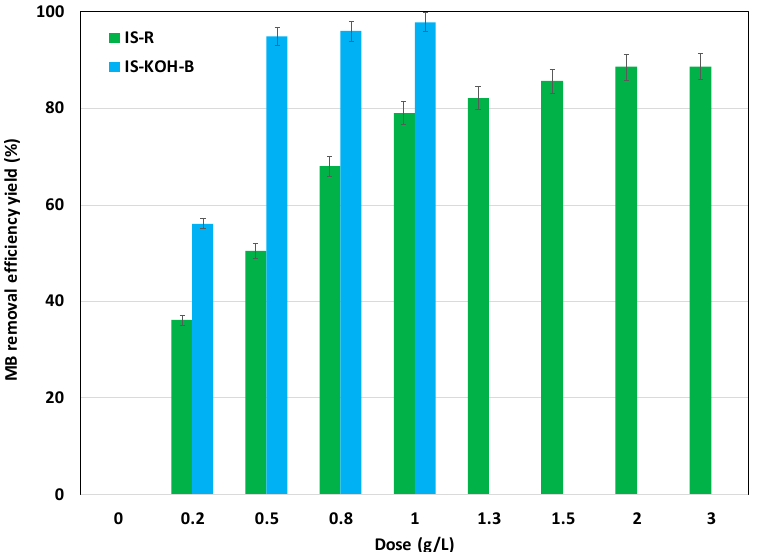
Figure 5. Effect of adsorbents doses on MB removal (C0 = 50 mg L − 1 ; pH = 6.8; D = 1 g L − 1 ; t = 3 h).